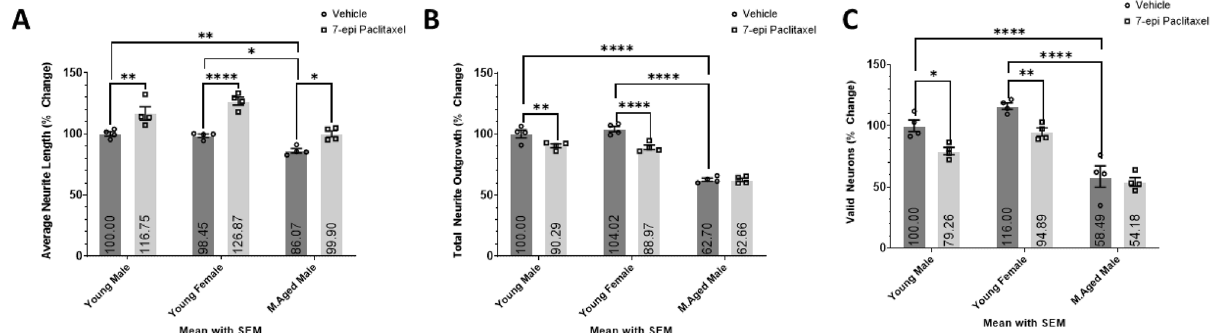
Figure 7. The age-dependent effects of 7-epi Paclitaxel. Histograms of the ( A ) average neurite length, ( B ) total neurite outgrowth, and ( C ) number of valid neurons expressed as percent change relative to the young adult male cohort with Vehicle treatment. Primary cortical neurons isolated from young adult male, young adult female, and middle-aged male mice cultured in Vehicle or 150 nM 7-epi Paclitaxel or 3DIV.